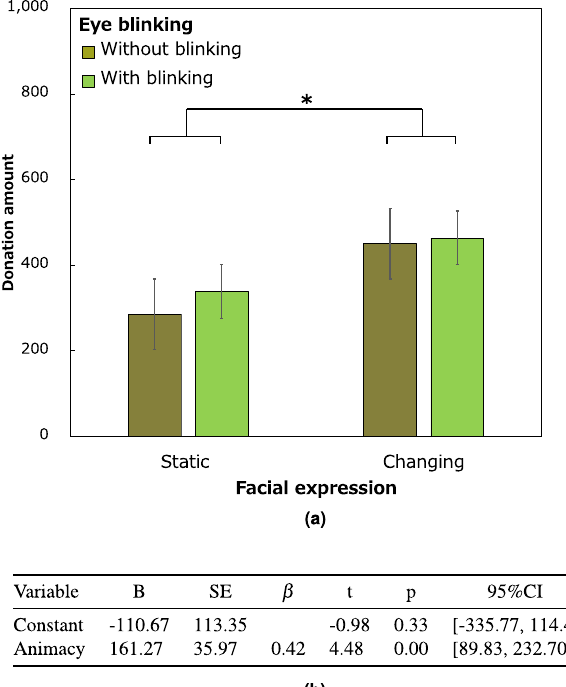
Figure 2. Results. ( a ) Participant donation rate. The error bars indicate standard errors. * p < 0.05 . ( b ) Multiple